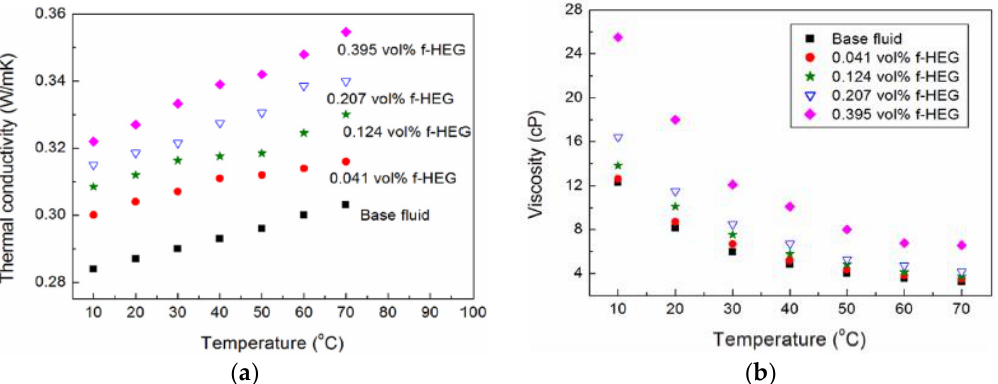
Figure 11. Thermal conductivity and viscosity diagram of ethylene glycol water-based GNs nanofluids with temperature [115].